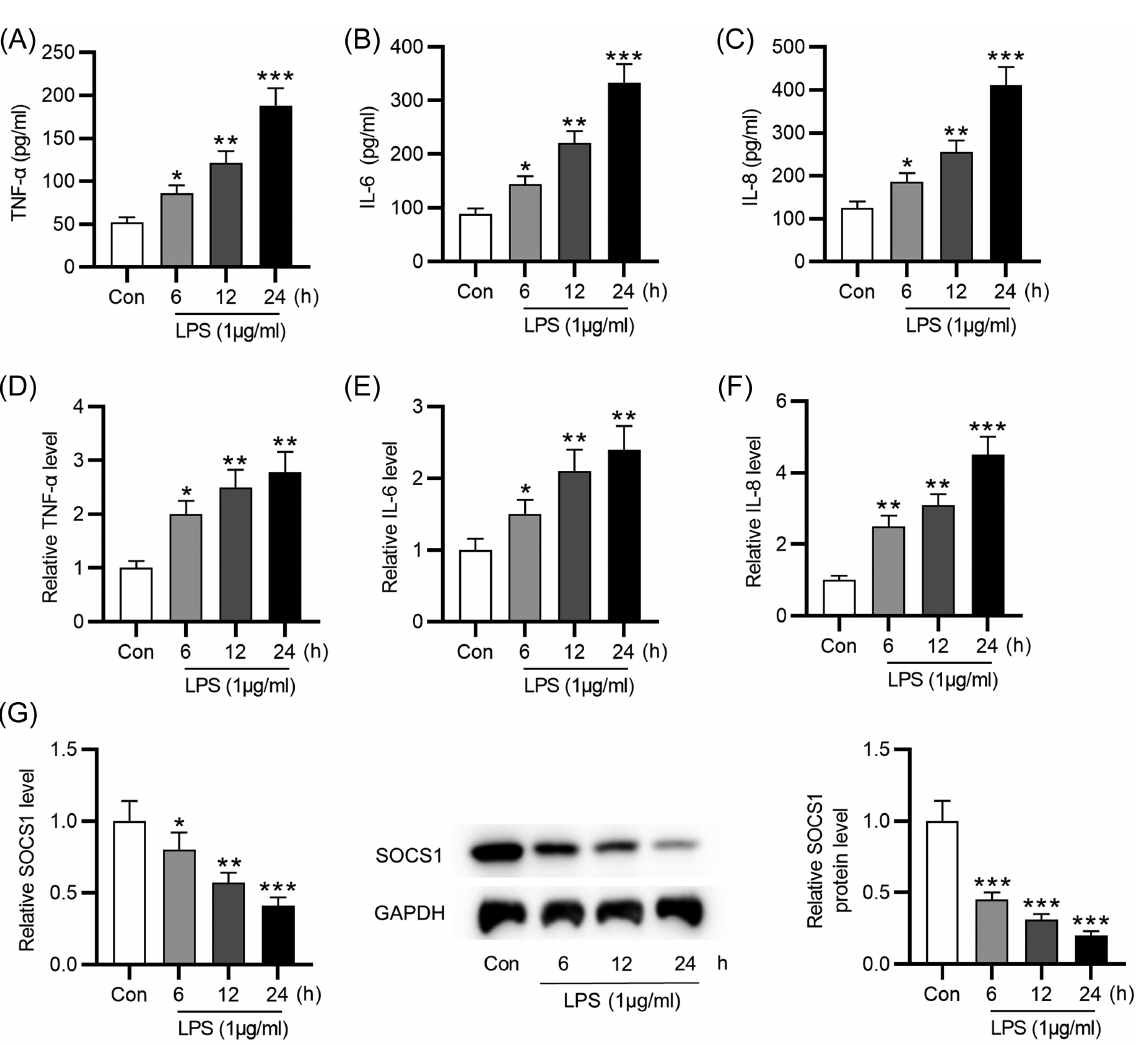
Figure 1. LPS induces inflammatory response and downregulates SOCS1 . The concentrations of TNF- α (A), IL-6 (B), and IL-8 (C) in LPS-treated RAW264.7 cells were detected by ELISA. The mRNA expression of TNF- α (D), IL-6 (E), and IL-8 (F) was detected by RT-qPCR. (G) SOCS1 mRNA and protein expression was measured by RT-qPCR and western blotting. * P < .05, ** P < .01, *** P < .001. LPS, lipopolysaccharide; ELISA, enzyme-linked immunosorbent